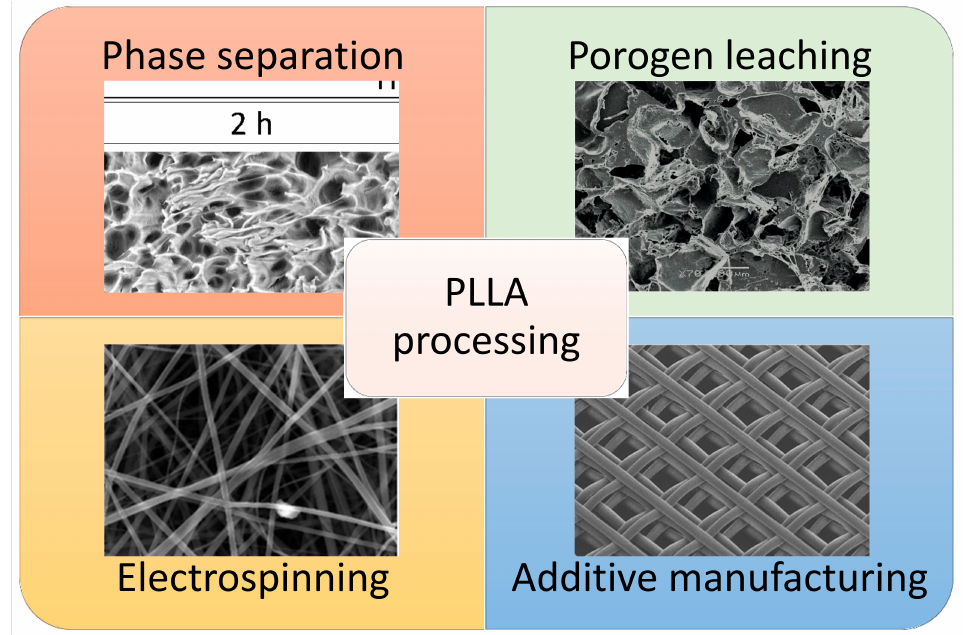
Figure 5. Pore morphologies of PLLA-based scaffolds prepared with some of the most used processing techniques. Reprinted with permission from MDPI [80,81], Hindawi [81], and Elsevier